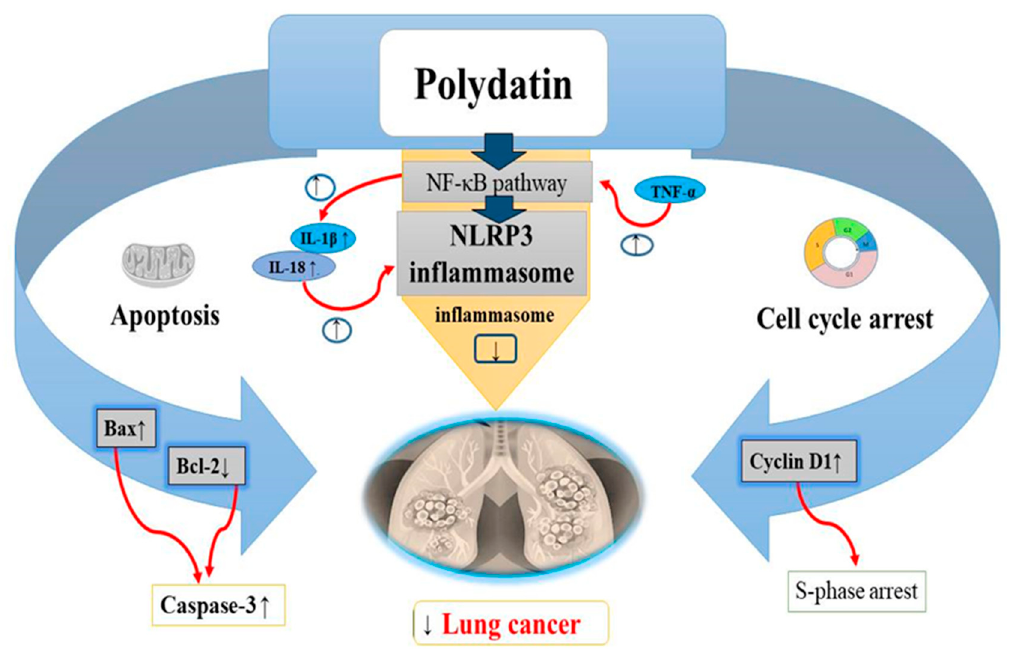
Figure 6. Anticancer effects of polydatin on lung cancer via the apoptotic pathway by increasing BAX levels, decreasing Bcl-2 levels and increasing caspase-3 levels, induction of cell cycle arrest at S phase by decreasing the cyclin D1 levels, and inhibition of the NLRP3 inflammasome by suppressing the NF-kB pathway in tumor cells. Upregulation ↑ Downregulation ↓ .